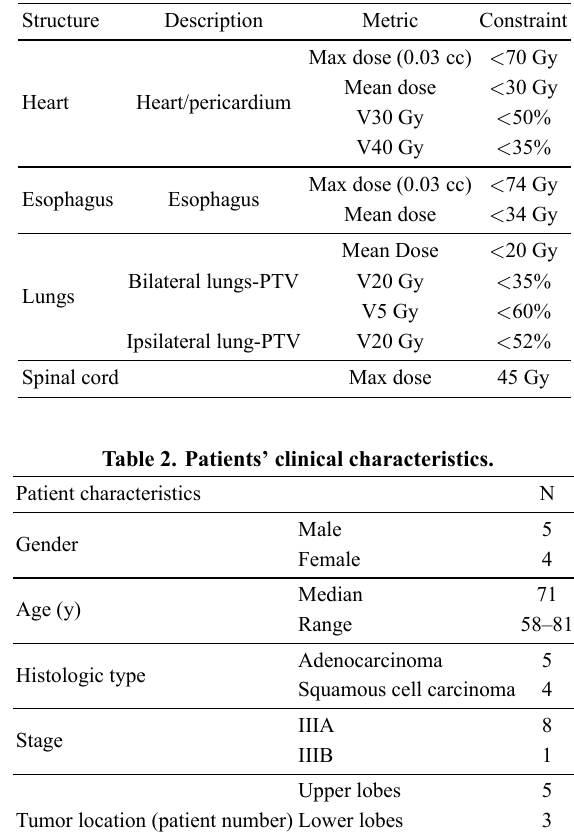
Table 1. Dose constraints for organs at risk.